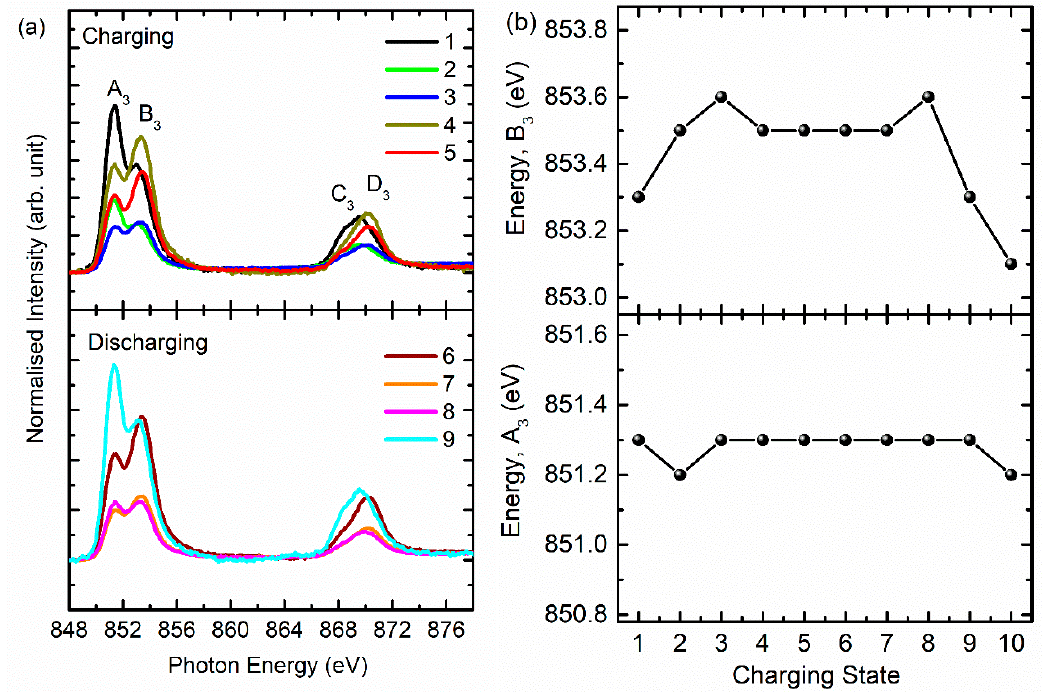
Figure 6. ( a ) Ni L -edge spectra and ( b ) energy of spectral features A 3 and B 3 of NCM811 cathode materials at stages 1–5 (charging) and 6–9 (discharging).